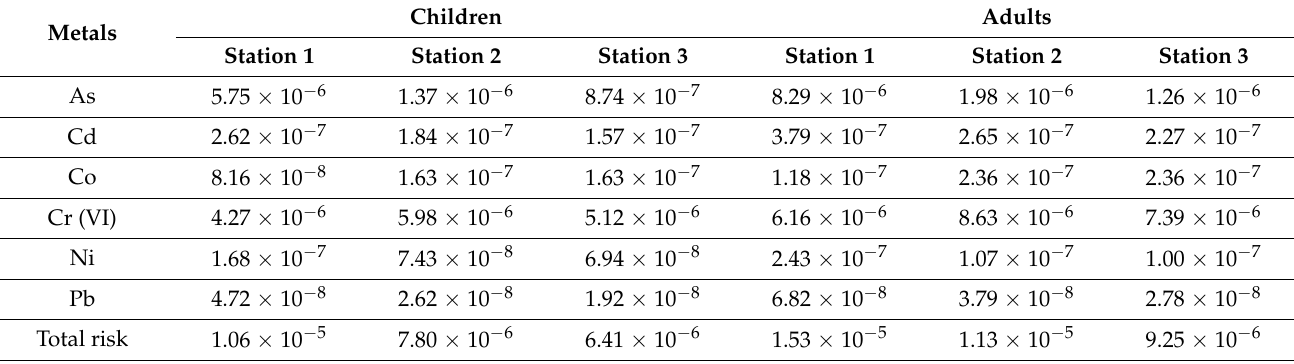
Table 6. The calculated values of carcinogenic risk for adults and children in the present